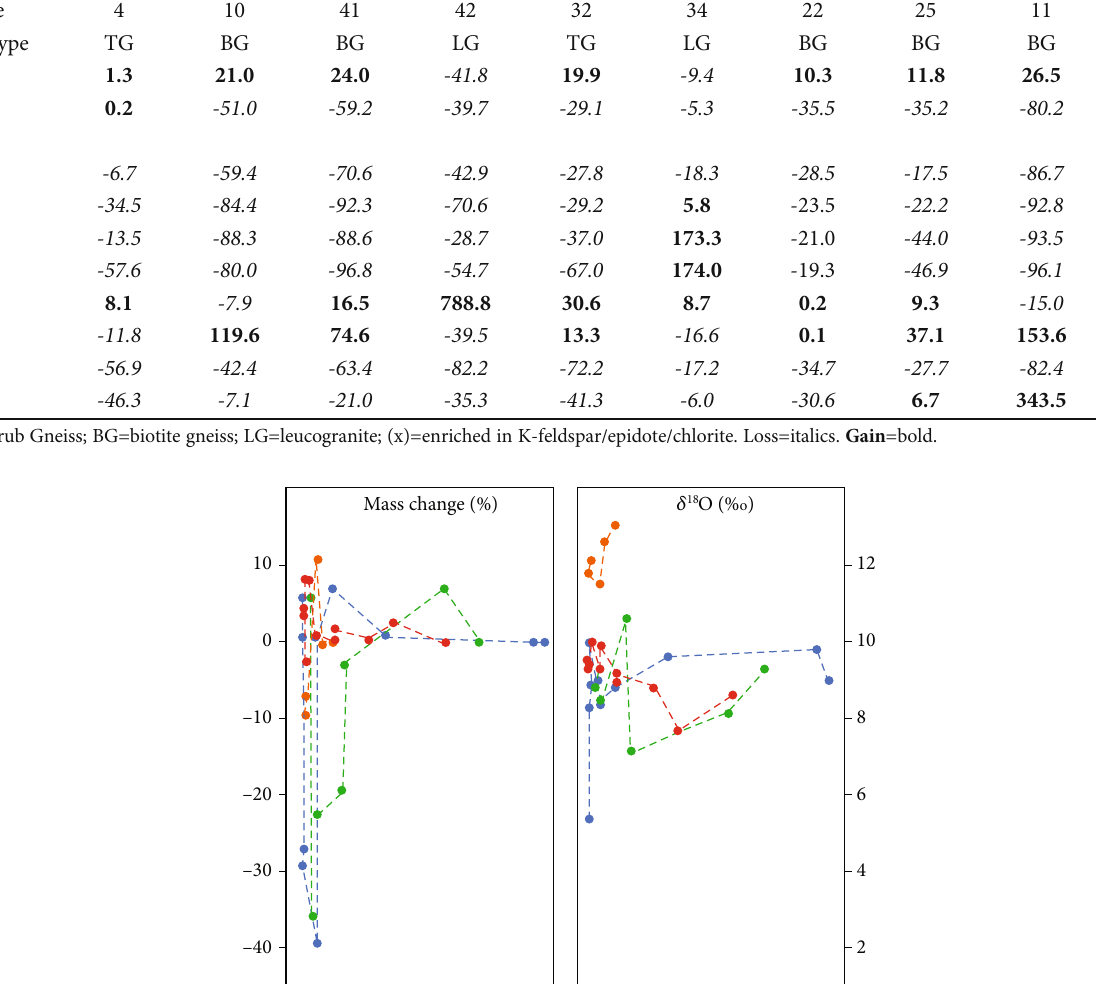
Table 2: The overall trend of changes in element concentrations in selected shear zone rocks relative to their protoliths, across the KMZ, is loss of Fe O , MgO, and CaO and gain of SiO 2 3 Area